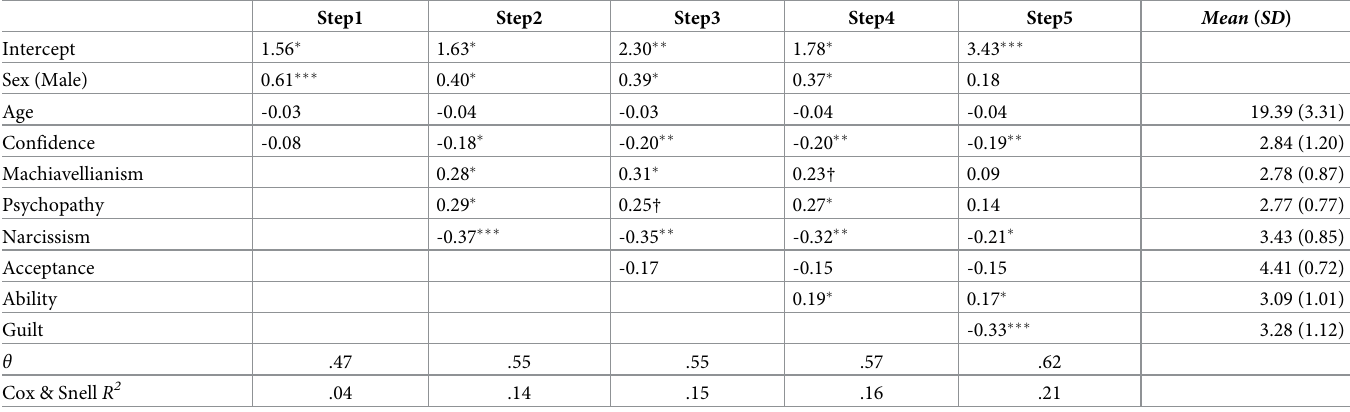
Table 2. Results of the hierarchical negative binomial regression.